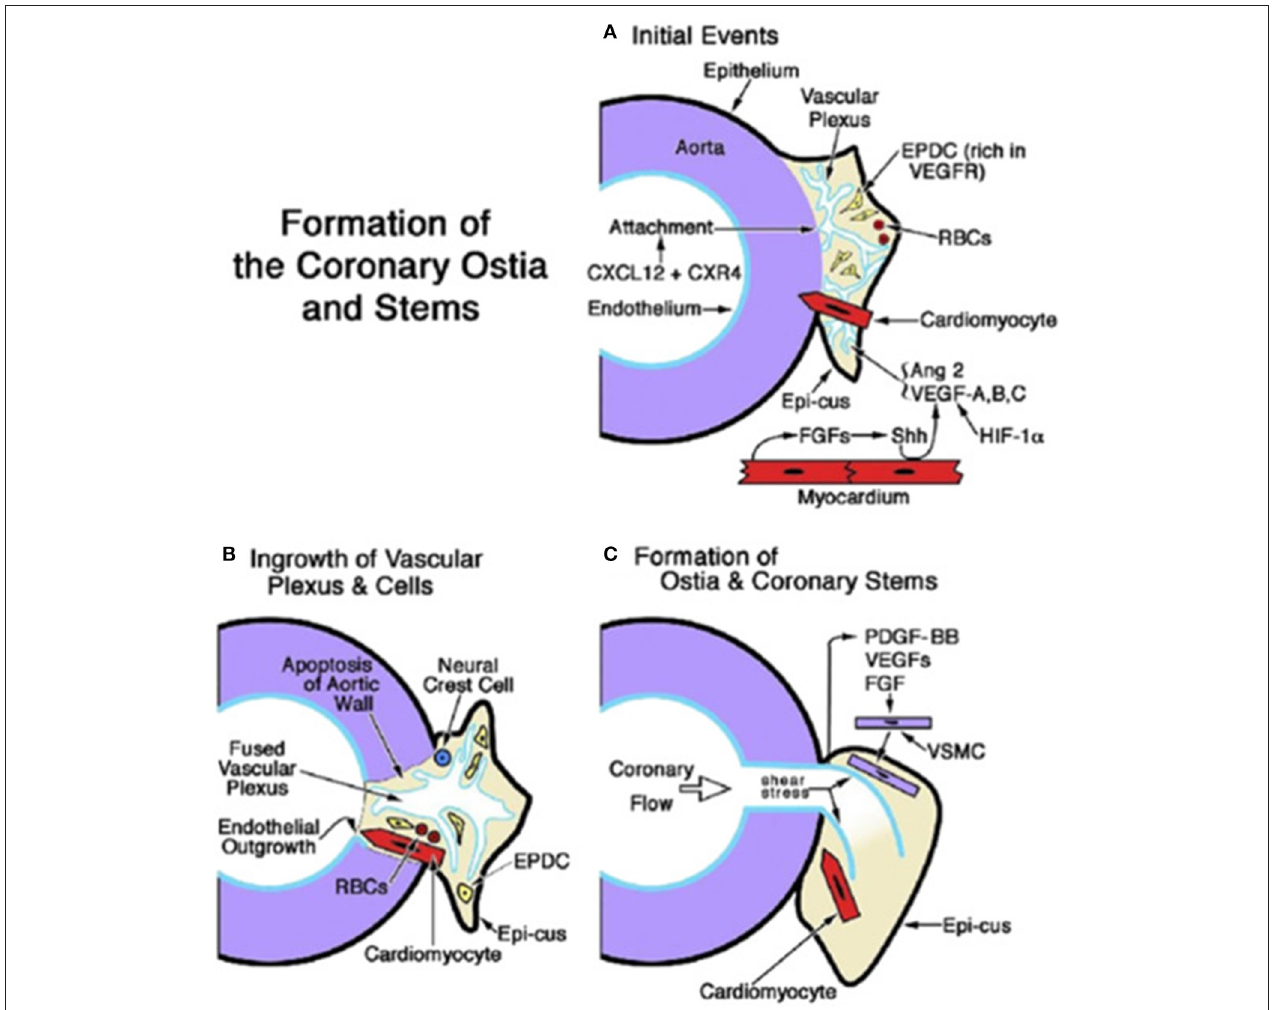
FIGURE 15 | Embryology of coronary artery orifices and main stems. (A) Formation of the coronary ostia and stems is initiated when the capillary ring that encircles the aortic root expands and attaches as a vascular plexus (in response to CXCL12 + CXR4). The sites of ostial formation are adjacent to an epicardial cusp (Epi-cus), a thickened portion of the subepicardium that contains epicardium-derived cells (EPDCs) that are rich in Vascular endothelial growth factor (VEGF) receptors and erythroblasts [red blood cells (RBCs)]. Cardiomyocytes guide the attachment of the vascular plexus. Fibroblast growth factors (FGFs) from the myocardium promote Sonic hedgehog (Shh) signaling, which, together with hypoxia inducible factor-1 (Hif-1), stimulates VEGFs and angiopoietin (Ang) 2, thus facilitating angiogenesis of the vascular plexus. (B) Myocardium-derived cardiomyocytes and neural crest cells facilitate the entry of the vascular plexus into an opening in the aortic wall, created by apoptosis. An endothelial ingrowth demarcates the pathway of the ostium formation. (C) The onset of coronary flow and shear stress is key to the remodeling of the vascular plexus. Differentiation, migration, and attachment of vascular smooth muscle cells (VSMCs) are influenced by (1) platelet-derived growth factor (PDGF)-BB activation in endothelial cells and the ligand’s interaction with PDGFR- β in VSMC progenitors; and (2) the influence of VEGFs and fibroblast growth factors (FGFs). From Tomanek and Angelini